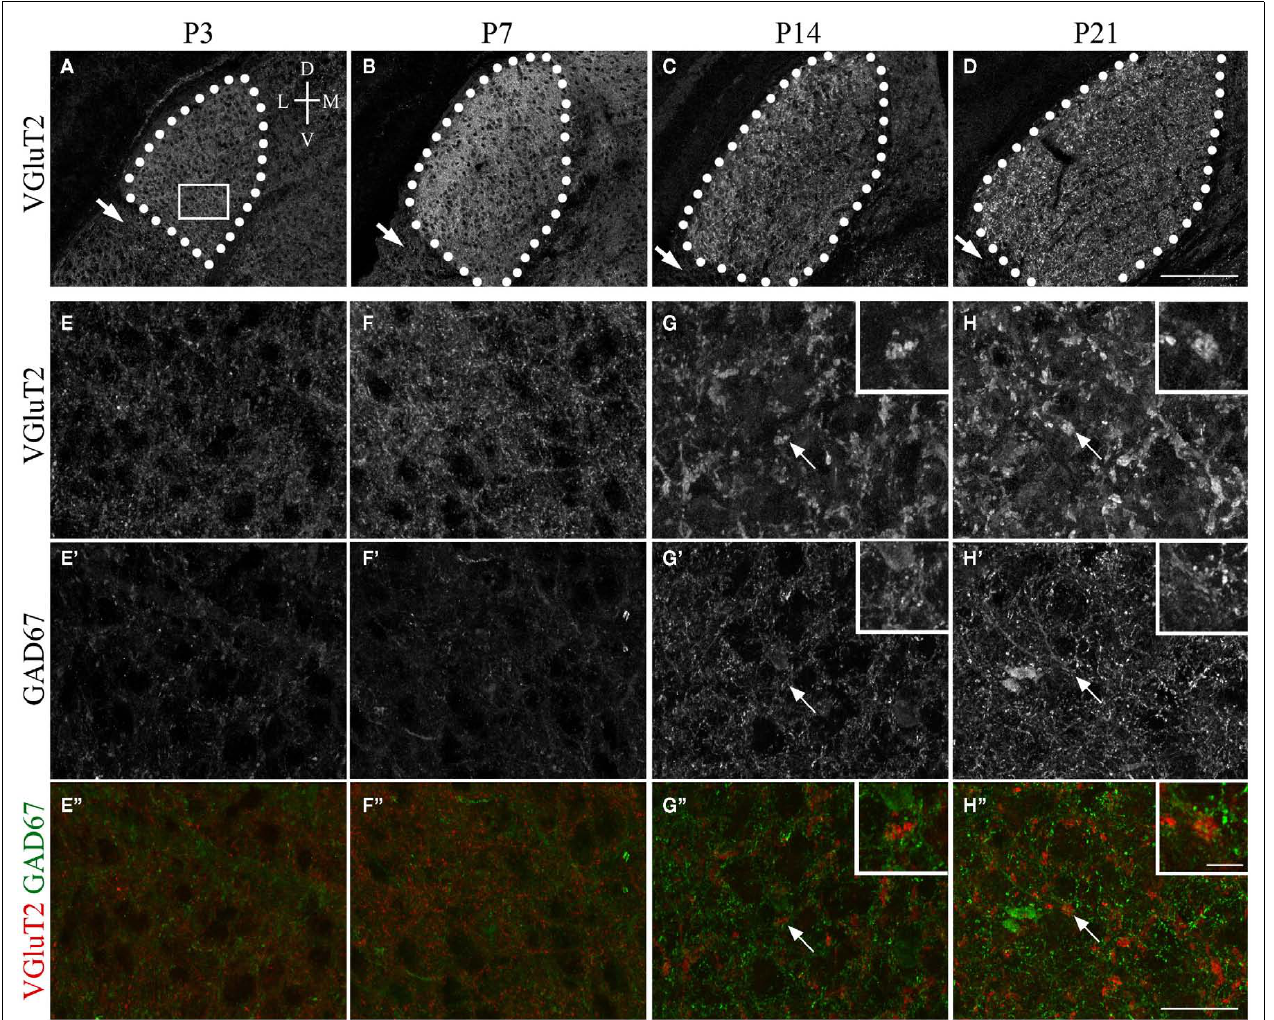
(E (cid:2) –H (cid:2) ) show the development of Gad67 inhibitory synapses in the postnatal dLGN. (E (cid:2)(cid:2) –H (cid:2)(cid:2) ) show merged images of retinal terminals (red) and inhibitory terminals (green). Arrows in (G,H) highlight presumptiveVGluT2-expressing RLPs [which are shown in higher magnification in the insets in (G,H) ]. All images were acquired with identical settings on a confocal microscope. Scale bar in (D) = 200 μ m for (A–D) , in (H (cid:2)(cid:2) ) = 25 μ m for (E–H (cid:2)(cid:2) ) , and in the inset in (H (cid:2)(cid:2) ) = 5 μ m for all